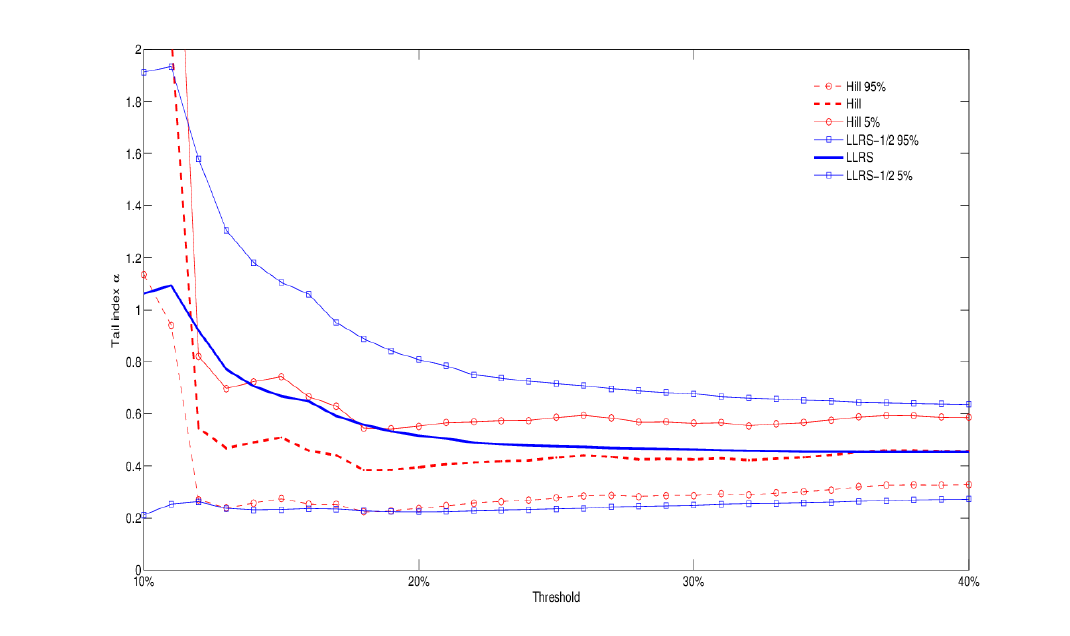
Figure 4. Occupancy level 3 type “Large Hotel”: tail index estimation (both Hill and LLRS-1/2 regression methods), with 90% confidence bands.